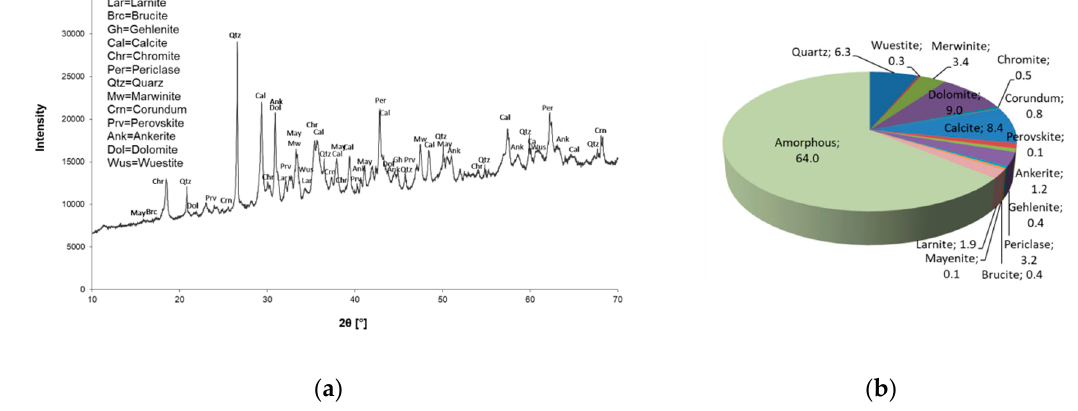
Figure 8. Powder X-Ray diffractogram of A/R: 1/1 specimen cured at 70 °C for 3 days ( a ) and Rietveld quantification (all in%) of the same specimen ( b ) .